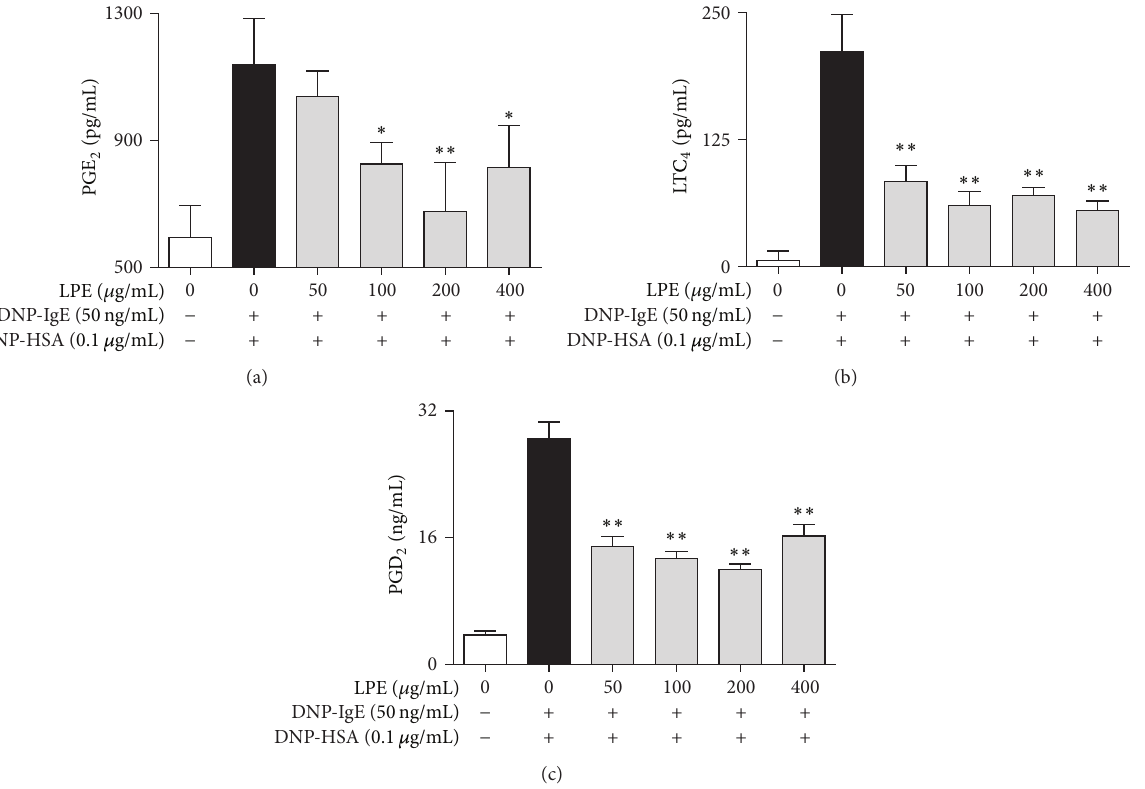
Figure 3: Inhibitory effect of LPE on proinflammatory lipid mediators. IgE-sensitized RBL-2H3 cells were preincubated with LPE for 1h before antigen treatment. PGE 2 , LTC 4 , and PGD 2 levels were determined as described in Section 2. Data are mean ± SD values of triple determinations. ∗ 𝑃 < 0.05 and ∗∗ 𝑃 < 0.01 versus DNP-HSA-treated group. (a) PGE 2 ; (b) LTC 4 ; (c) PGD 2